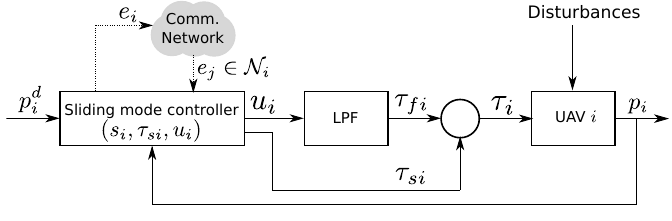
Figure 2. Block diagram of the control